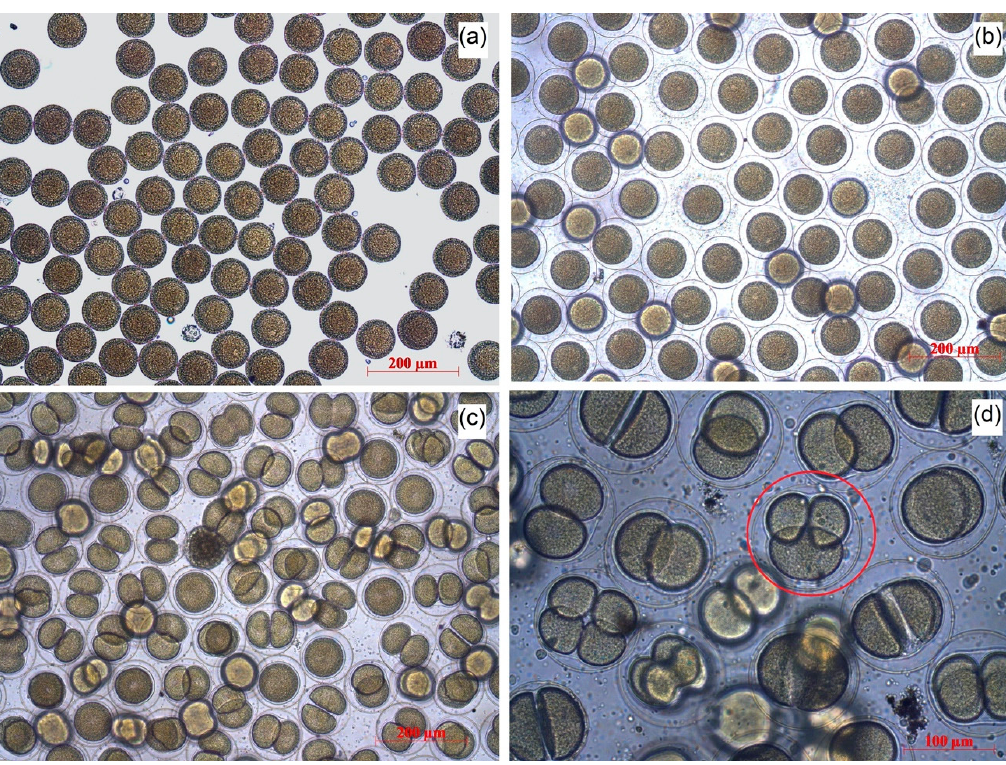
Figure 1. The stages of S. intermedius embryo development: ( a ) unfertilized eggs; ( b ) fertilized eggs; ( c ) normal embryo development; ( d ) the example of impaired development.